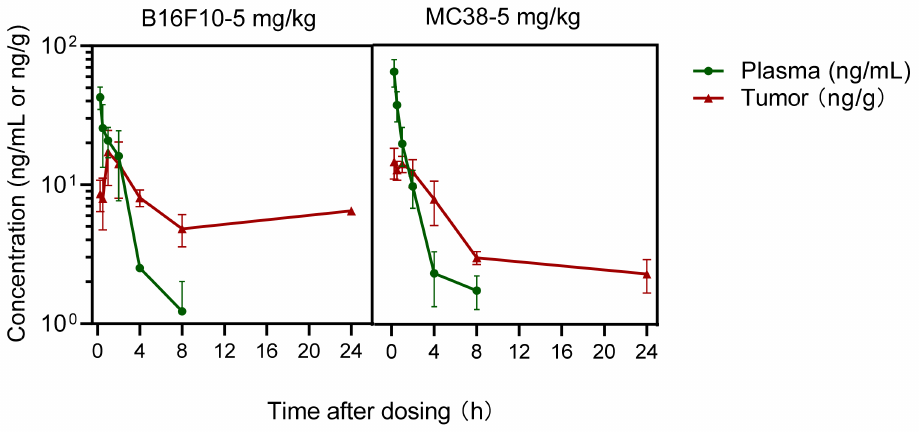
Figure 7. Mean plasma and tumor concentration-time profiles of active metabolite YPD-29B in B16F10 melanoma and MC38 colon cancer xenograft mice after the last oral administration of IMMH-010 maleate at a dose of 5 mg/kg for 19 days ( n = 4). Data are expressed as mean ±